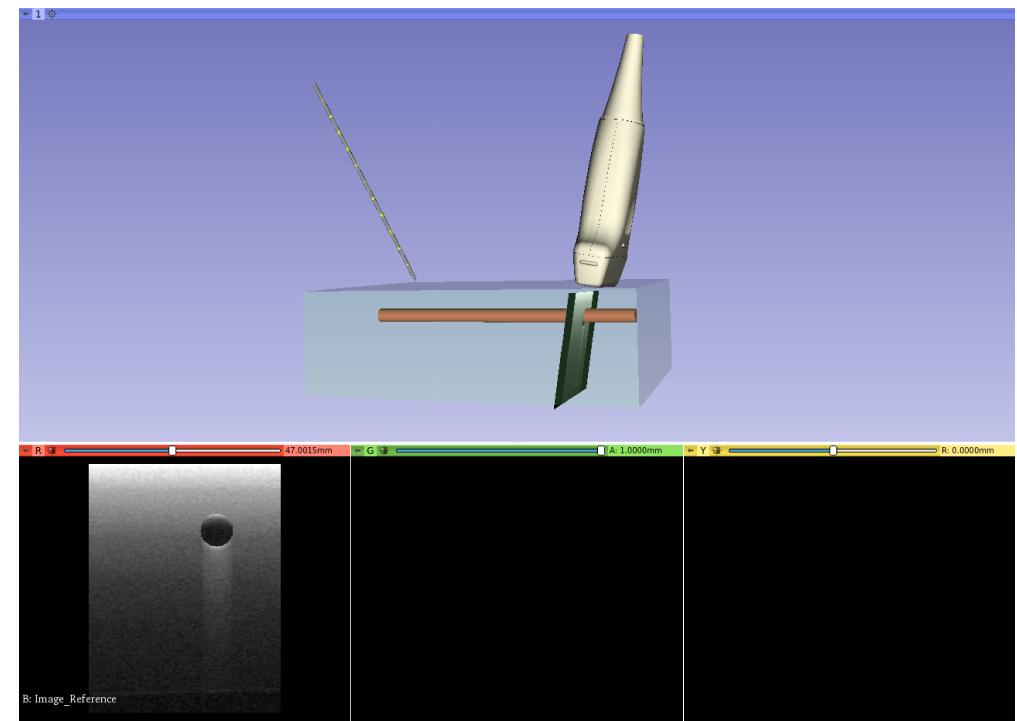
Figure 4. Simulation of an ultrasound guided procedure. The aim was to move the probe according to the data coming from a distance